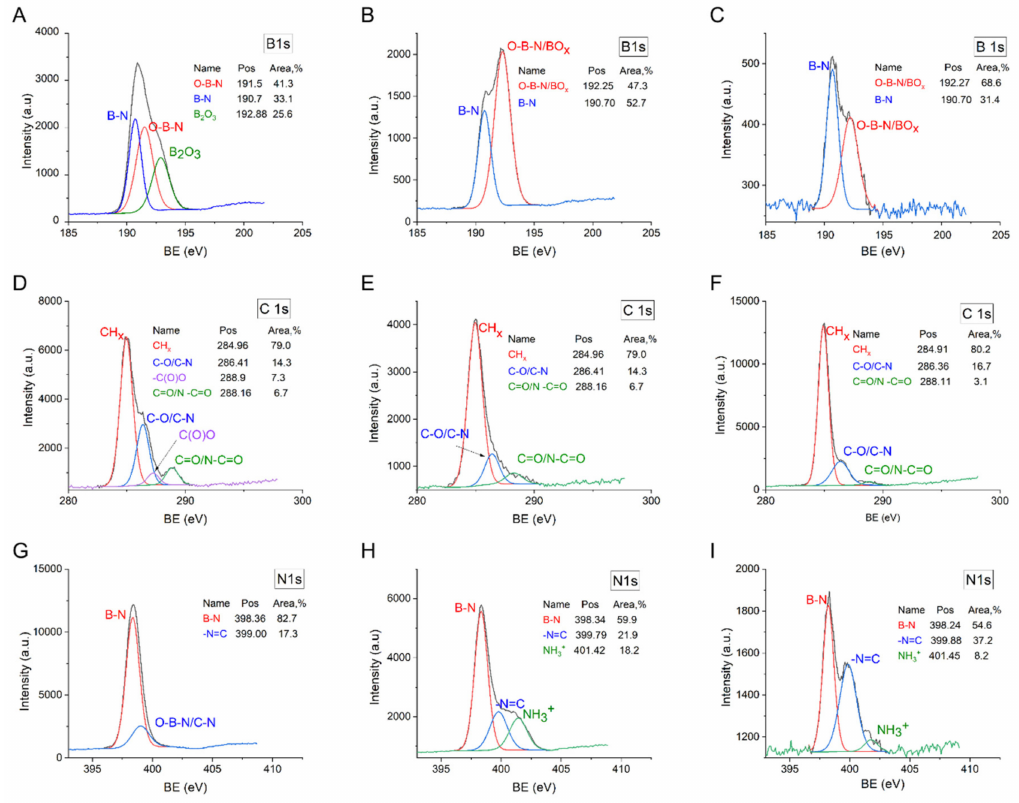
Figure 4. High-resolution XPS B 1s ( A – C ), C 1s ( D – F ), and N 1s ( G – I ) spectra of BNNPs PT ( A,D,G ), EDA-BNNPs PT ( B,E,H ), and FA / EDA-BNNPs PT ( C,F,I ) samples. BE: binding